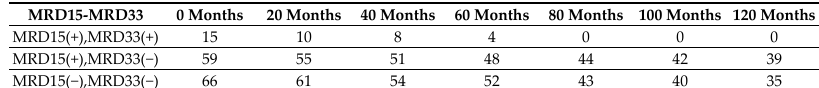
Censored events are marked with a tick through the line . Number of patients at risk. MRD15-MRD33